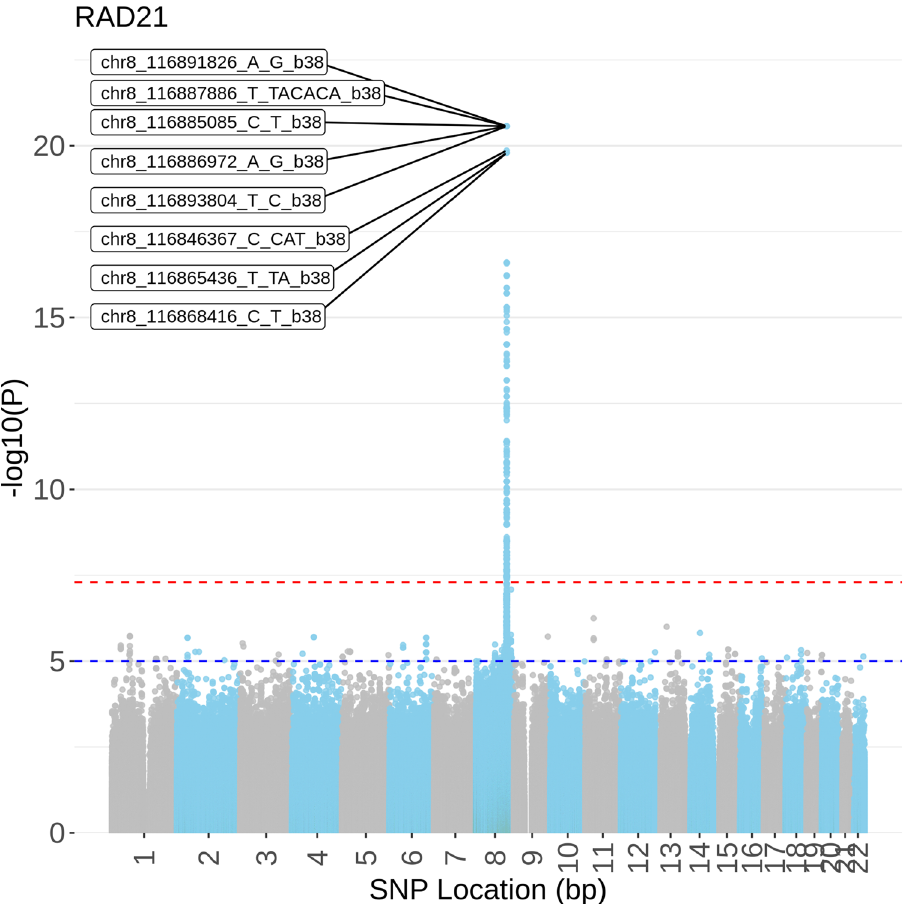
Figure 1. Manhattan plot of all eQTL p-values between genome-wide SNPs and RAD21 expression across all GTEx tissues. The top 5 SNPs are highlighted. Despite there being no similar standard for genome-wide eQTL studies, the red (p < 5 × 10 –8 ) and blue (p < 1 × 10 –5 ) dashed lines represent the typical p-value thresholds from GWAS studies as a